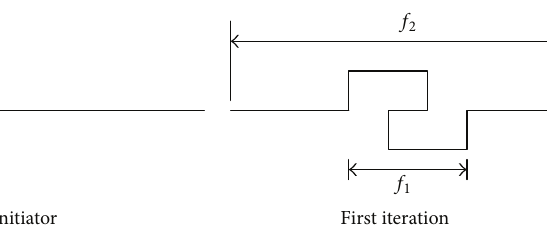
Figure 1: The recursive procedure of the Giuseppe Peano fractal.